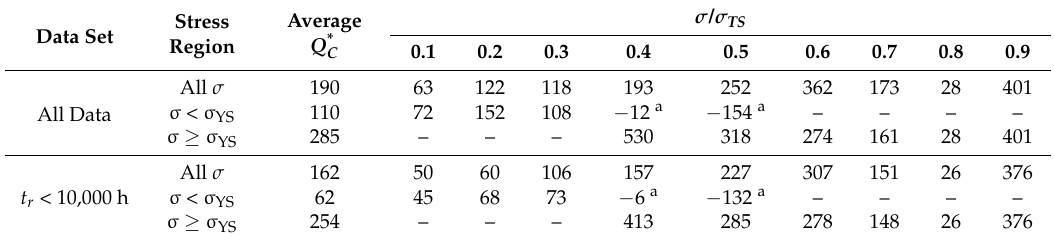
Table 1. Inconel 617 Q ∗ values (kJ/mol) determined using Arrhenius C